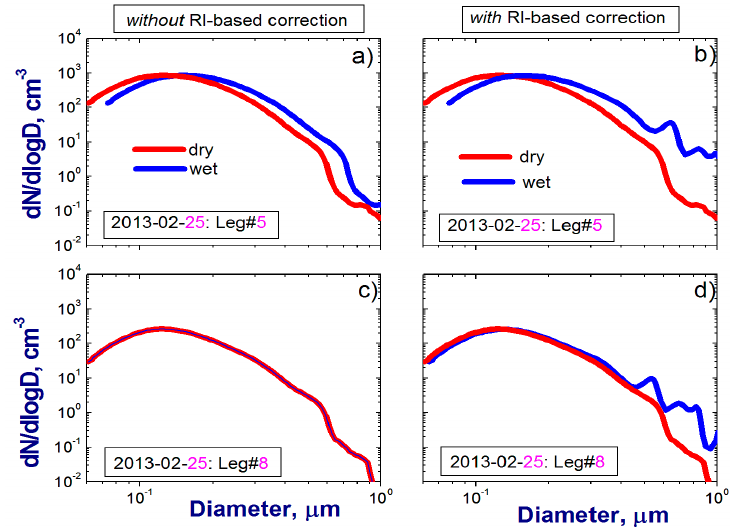
Figure 7. Example of size distributions obtained for two FLs on 25 February 2013 with large ( a , b ) and small ( c , d ) values of ambient RH, respectively. Measured dry size distributions (red) are converted into their wet counterparts (blue) without ( a , c ) and with ( b , d ) the size-dependent scaling factor.